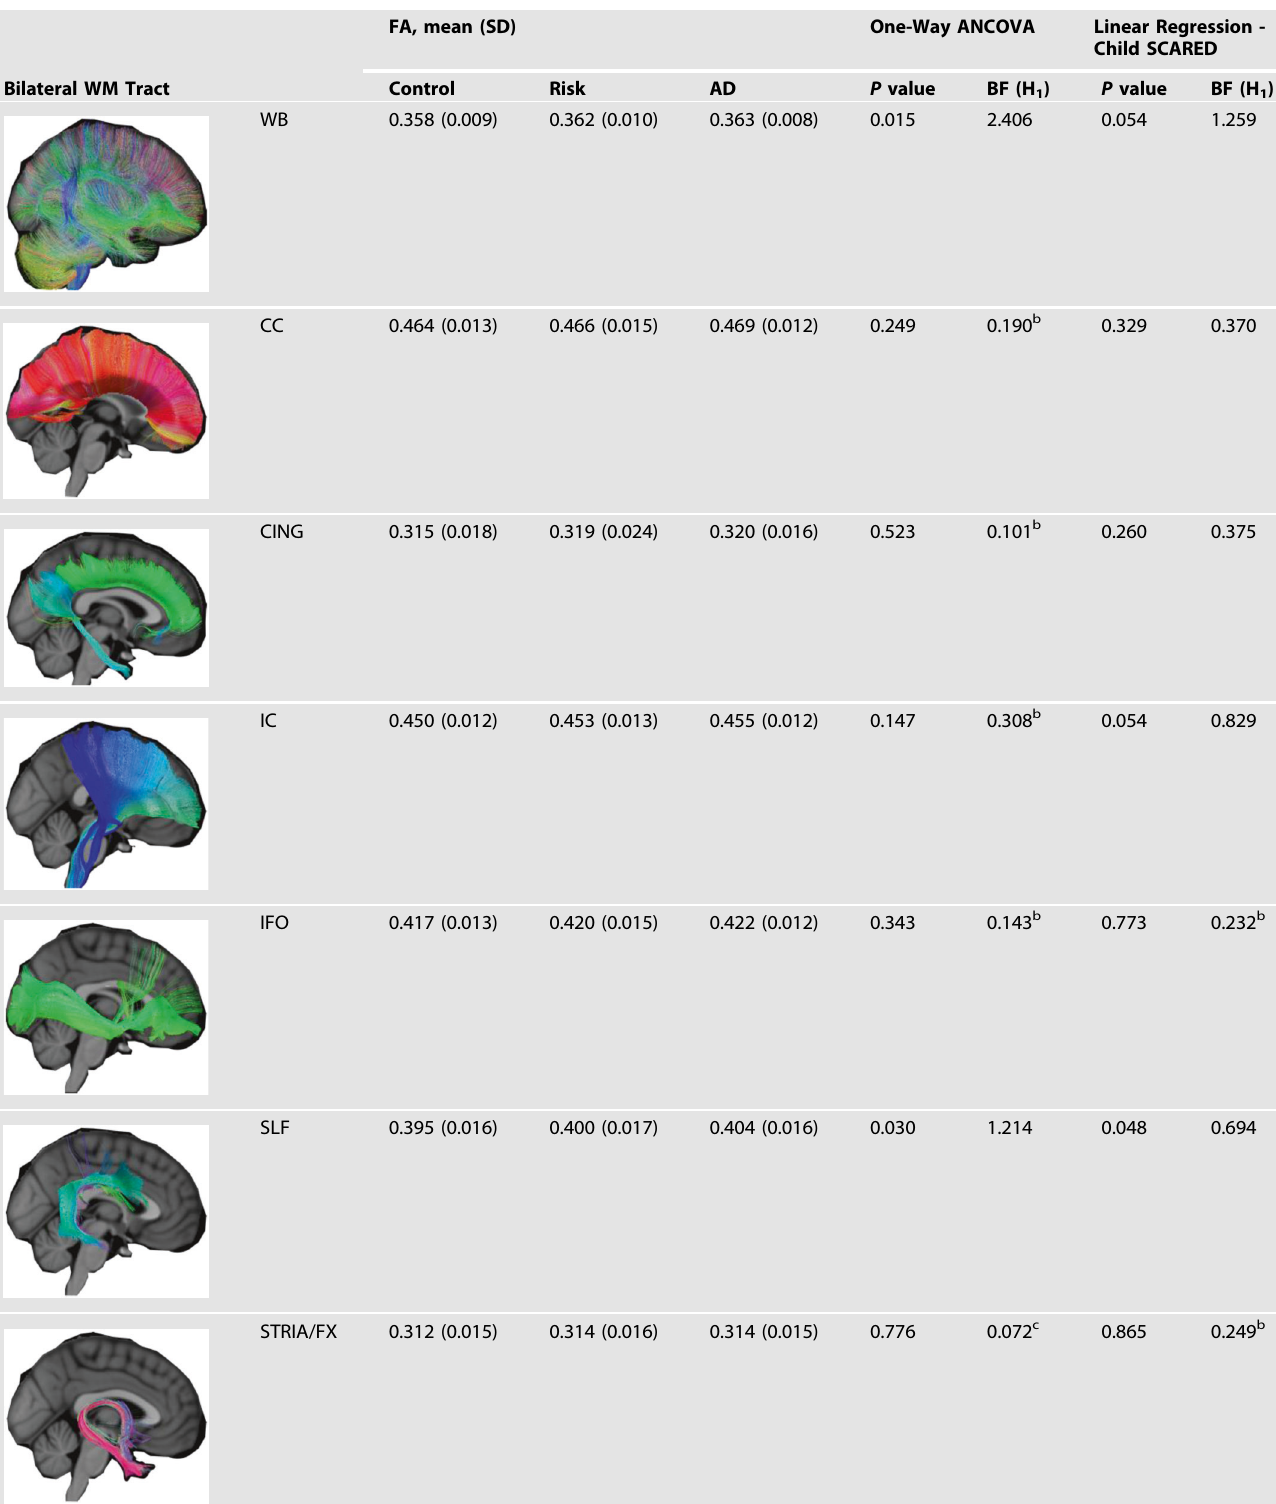
Table 3. Group differences in tract FA and dimensional relations with SCARED scores at study entry a